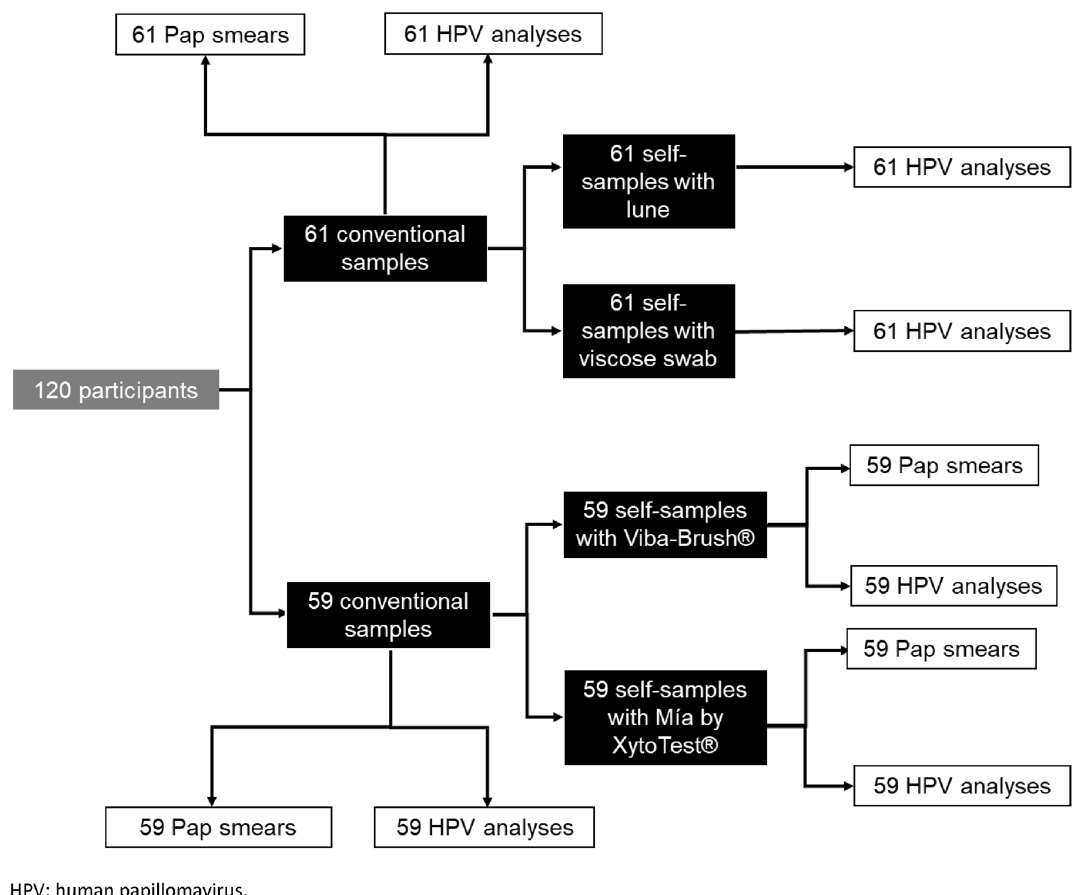
Figure 2. Number of samples and tests distributed among patients.